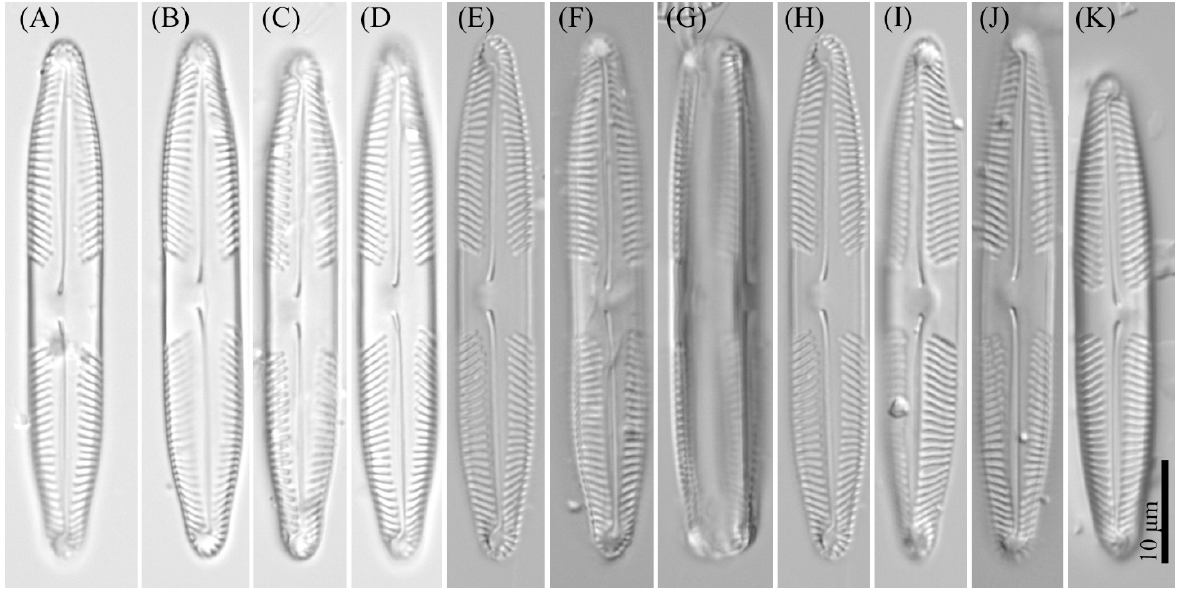
Figure 9. Pinnularia insolita Kezlya, Maltsev, Krivova et Kulikovskiy sp. nov. Strain VP280 slide No. 07038. Light microscopy, differential interference contrast. ( A – F ) Valve face. ( A ) Holotype. ( G ) Cell in girdle view. ( H – K ) Valves from the wild sample.